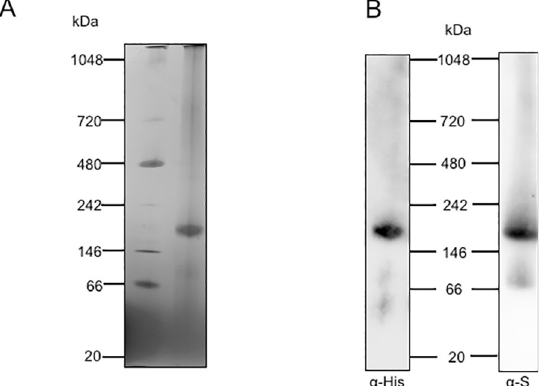
Fig 4. Determination of the size of the complex of EhDHS1 and EhDHS2. (A) Purified Recombinant EhDHS1 and 2 were co-expressed, copurified, and were subjected to 4–16% BN-PAGE. After electrophoresis the gel was destained. Native page marker (Invitrogen) was used as a protein standard. (B) Immunoblot analysis following BN-PAGE of co- expressed N-terminal His-tagged EhDHS1 and C-terminal S-tagged EhDHS2, using anti-His and anti-S tag antibodies